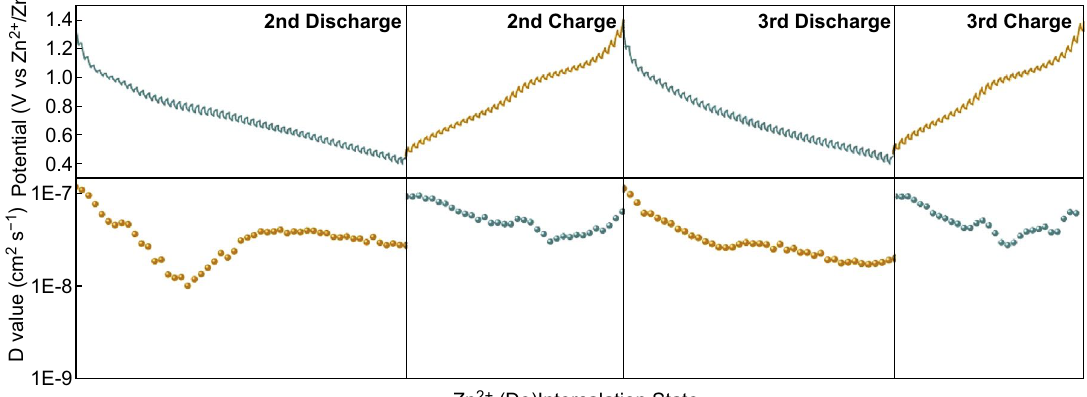
Fig. 4 Charge–discharge curves in the galvanostatic intermittence titration techniques (GITT) measurements (above) and corresponding Zn 2+ diffusion coefficient at different discharge/charge states (below) of